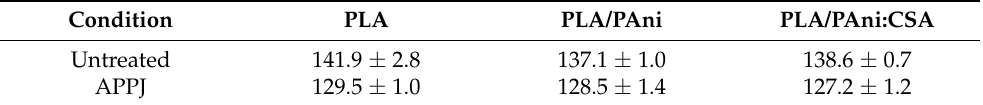
Table 2. Water contact angles ( ◦ ) of untreated and APPJ-treated nanofibrous scaffolds.